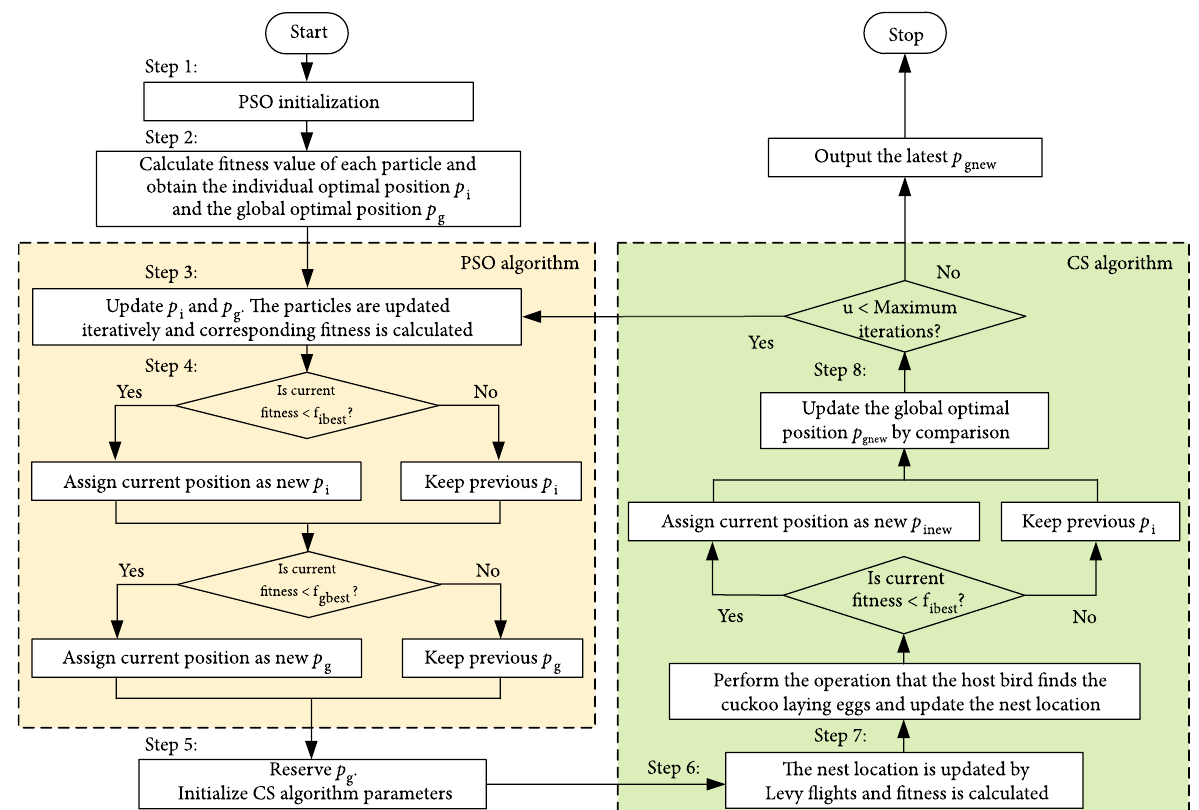
Figure 5: The calculation process of the PSO-CS hybrid